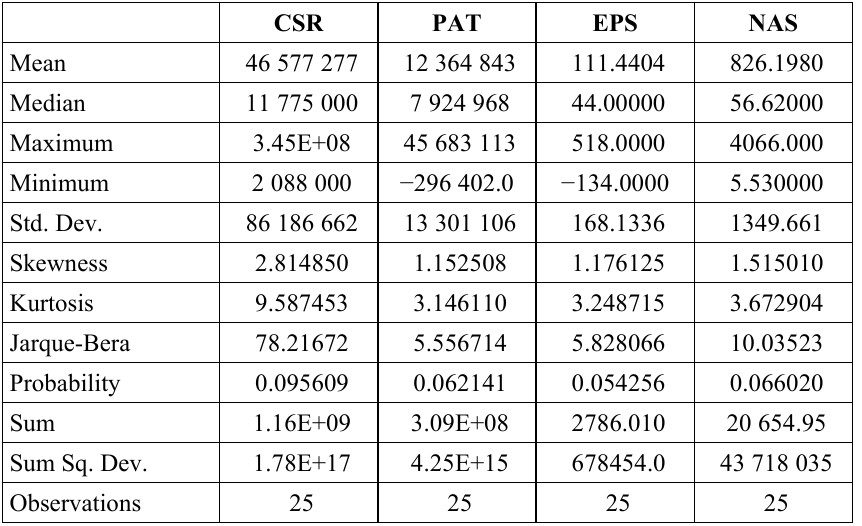
Table 4. Summary